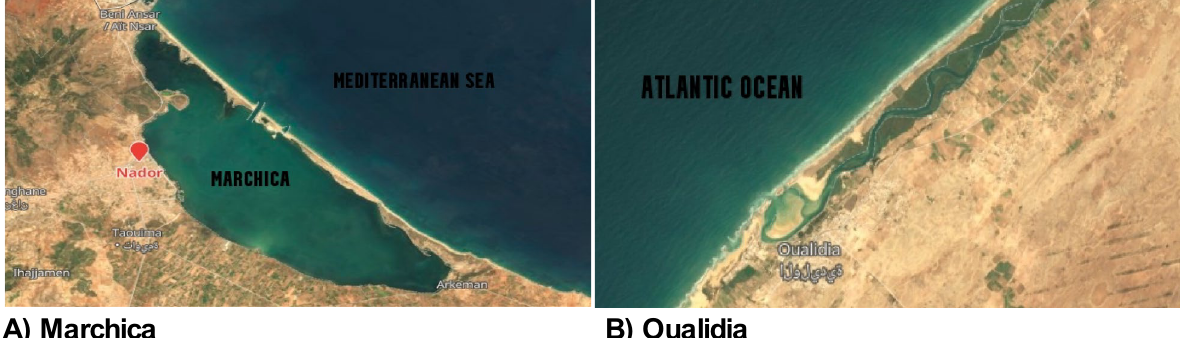
Figure 5. Sampling locations: ( A ) Marchica Lagoon (Image©2022Google) and ( B ) Oualidia Lagoon (Image GeoEye from Google Earth,